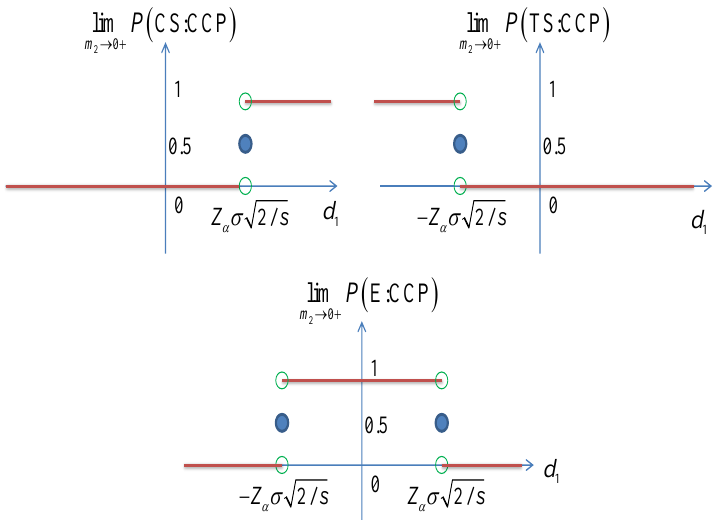
Figure 2. The graph of the three limits (8)–(10) by three